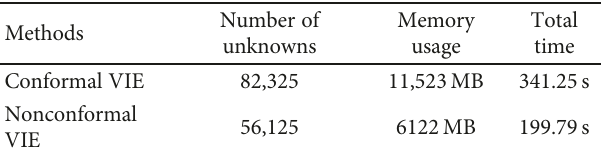
Figure 5: Bistatic RCS in VV polarization from a coated dielectric sphere with the relative permittivities of ε r = 1 0 – 1 0 j , an inner radius of r and ε r 2 = 0 5 m . radius of r 2 Table 1: Comparison of numerical performance between conformal VIE and nonconformal VIE.